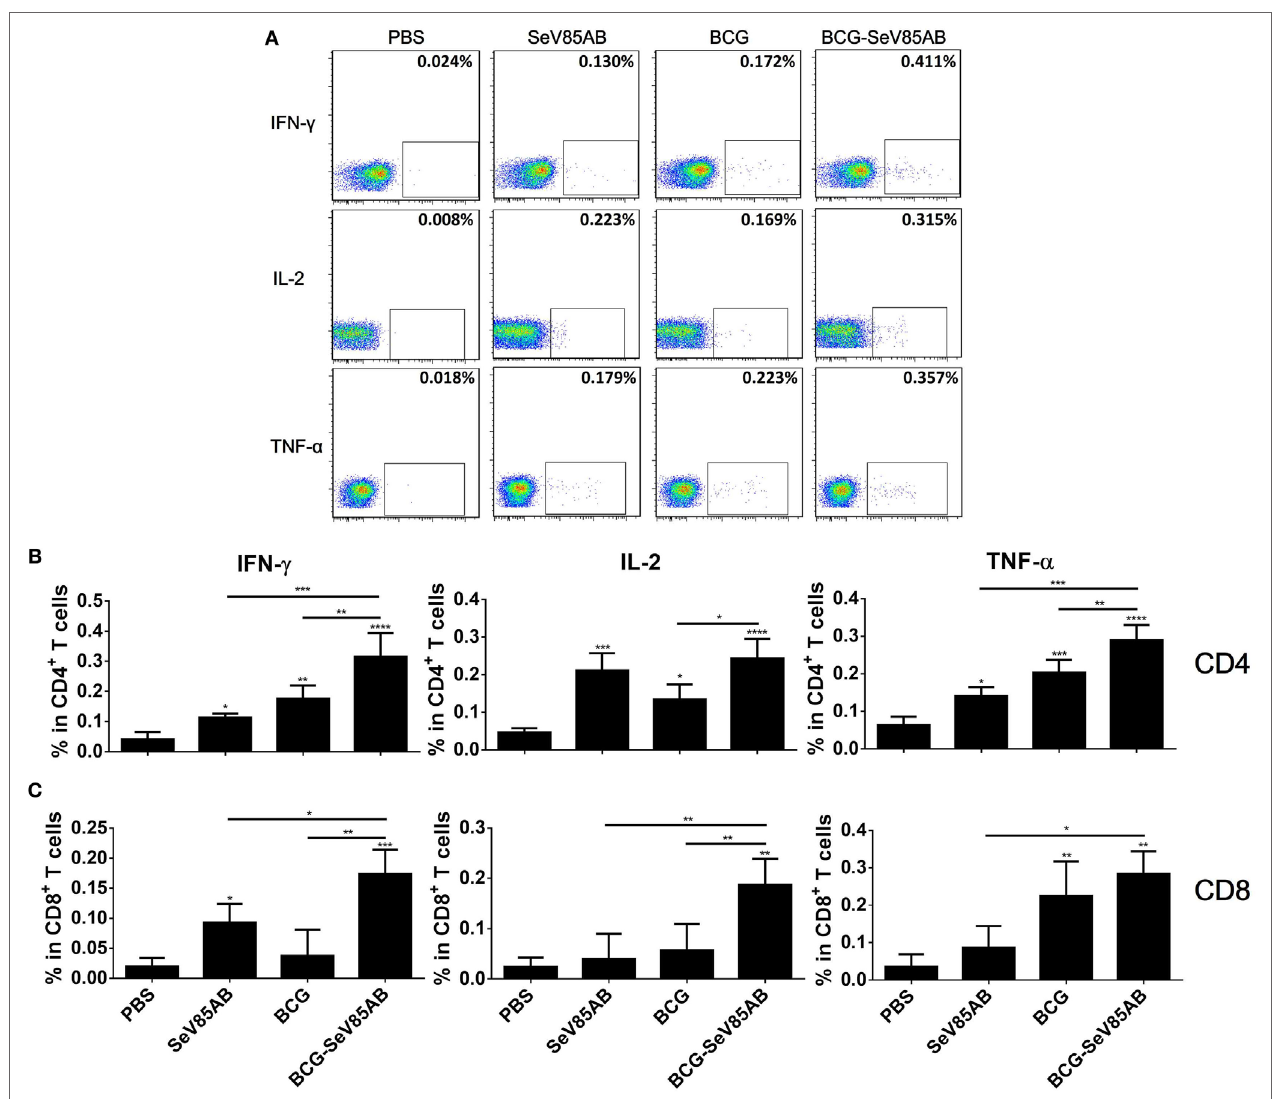
FigUre 4 | Flow cytometric analysis of ICS in the lung cells of vaccinated mice. Lung cells were collected, stimulated, and analyzed for cytokine production by ICS assay as described for splenocytes in Figure 2 . Representative flow cytometric data plots from CD4 + T cells (a) and summarized data of single cytokine producing CD4 + T cells (B) and CD8 + T cells (c) are shown. The percentages of responding cells were compared as indicated. Data are representative of two independent experiments with at least four mice per group. * P < 0.05, ** P < 0.01, *** P < 0.001, and **** P <